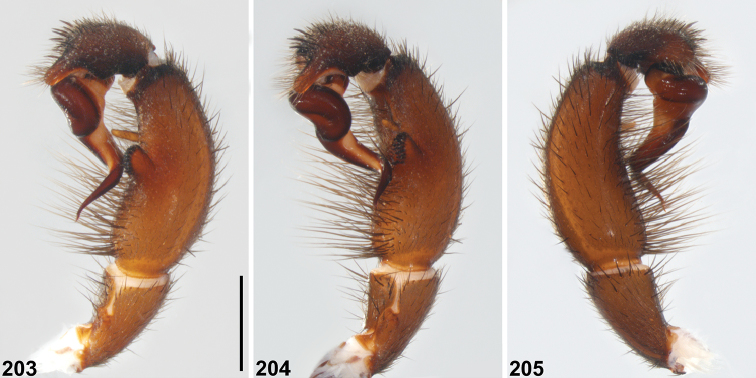

Idiosoma
incomptum sp. n., male holotype (WAM T99997) from Carnarvon (Western Australia; CAR), pedipalp. 203 Retrolateral view 204 Retroventral view 205 Prolateral view. Scale bar 2.0.